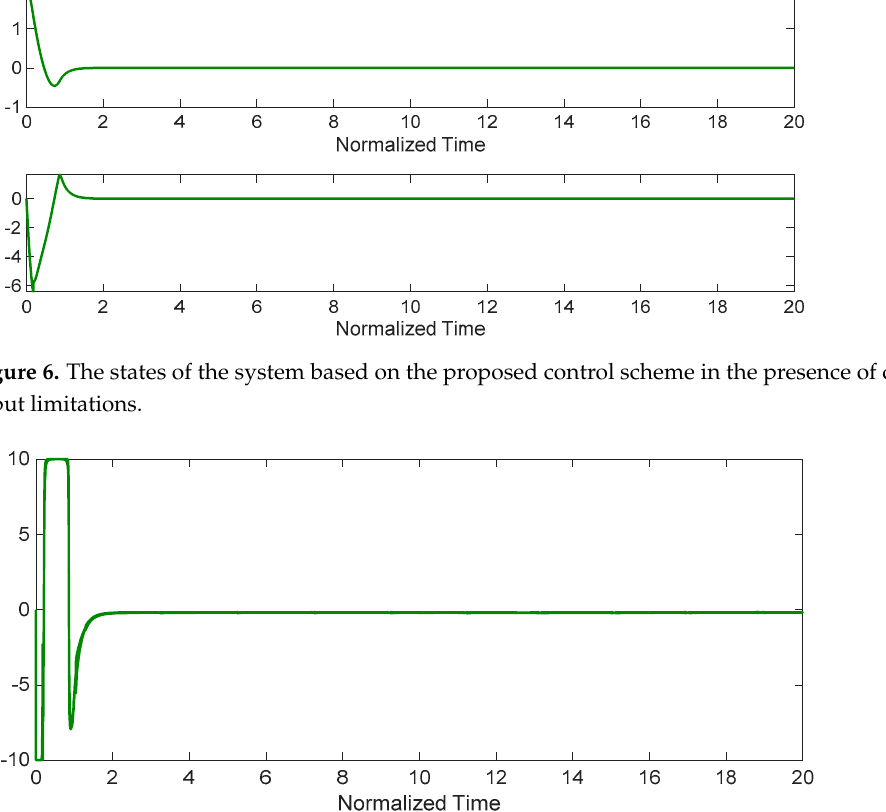
Figure 7. The control input of the closed-loop system based on the proposed control scheme in the presence of control input limitations. presence of control input